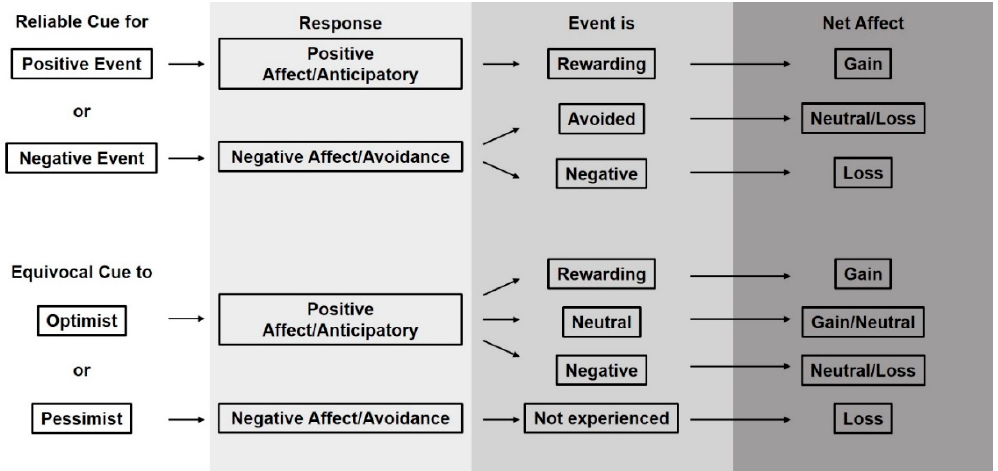
Figure 5. Predicted net welfare impacts of animal responses to reliable cues and equivocal cues for different types of events (rewarding, neutral, or negative).